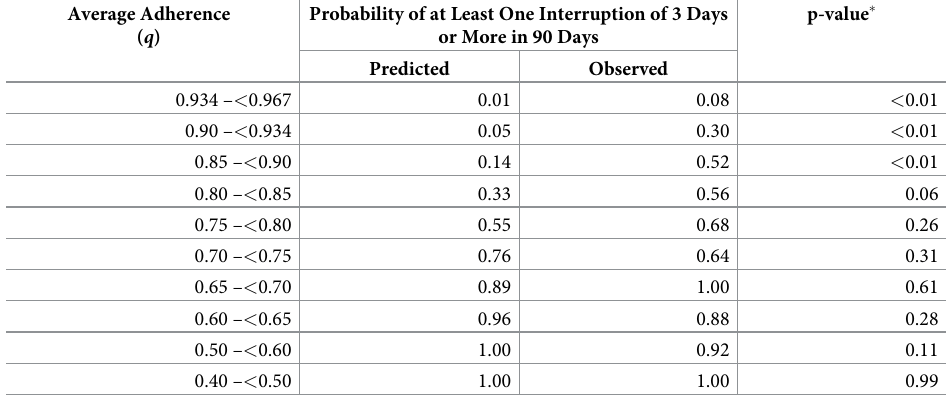
(cid:3) Two-sided p-values were computed using the exact binomial test for goodness of fit. The midpoint of the adherence intervals provided the q parameter input for the probability model generating the point